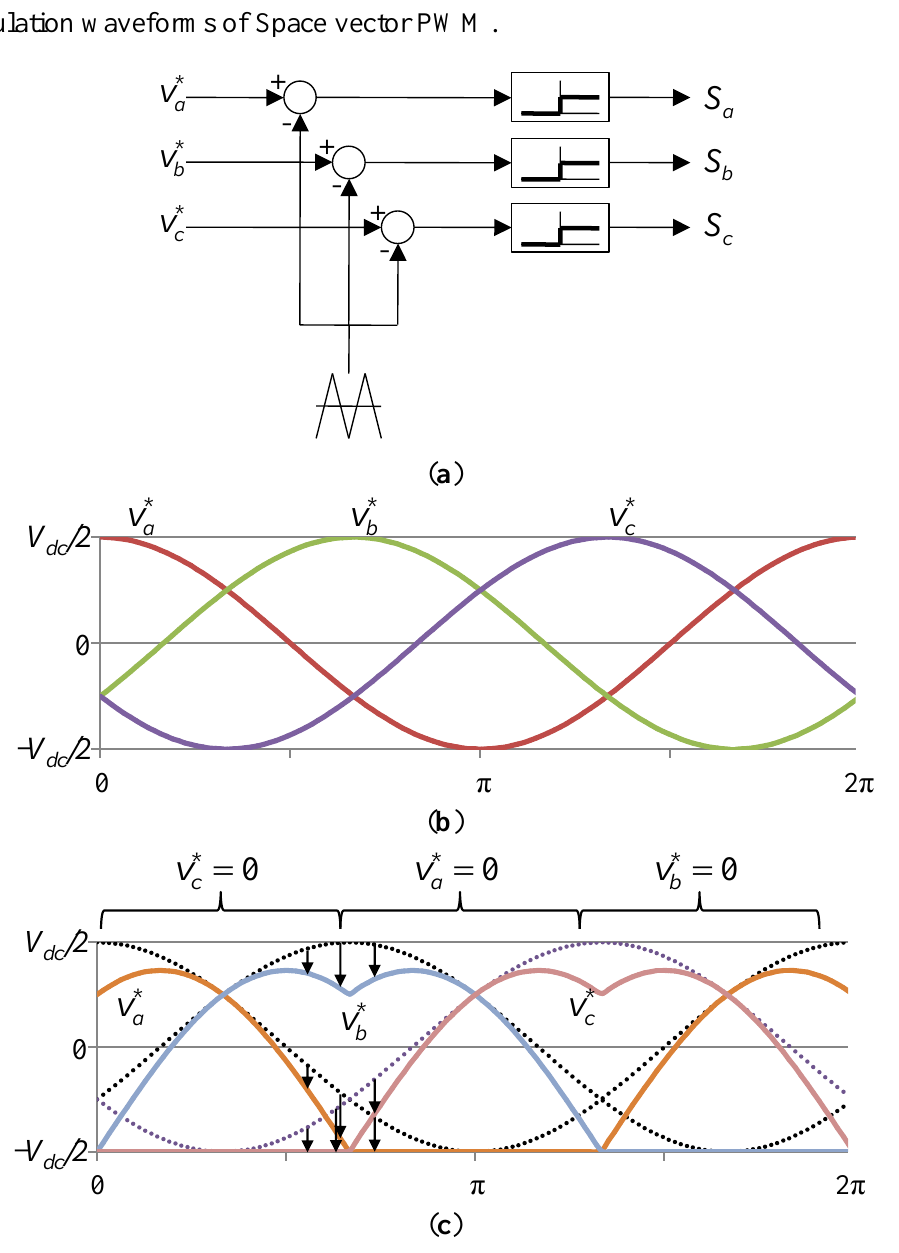
Figure 12. Comparison of the input voltage control methods for the stepper motor. ( a ) Signal block diagram of the PWM. ( b ) Modulation waveforms of SPWM. ( c ) Modulation waveforms of Space vector